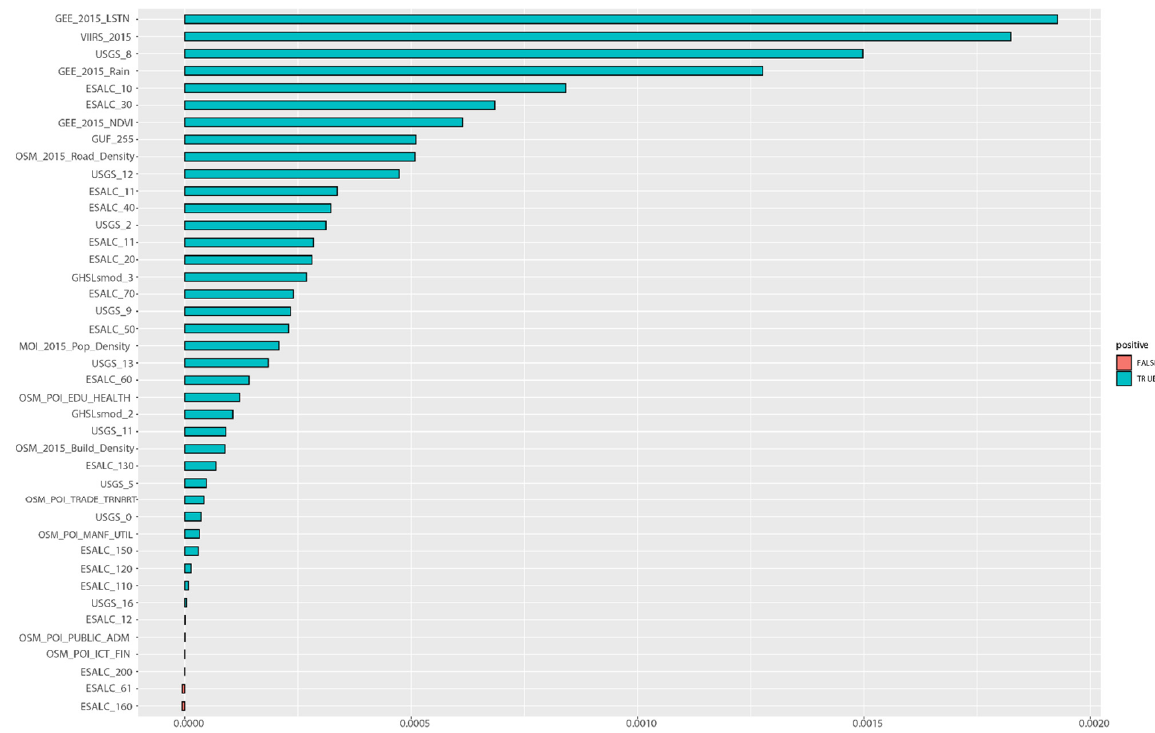
Figure 14. Result of Variable Importance (VIMP) analysis on predicting poverty headcount rates of 2015 (based on RF’s outcome). Source: Calculation and graphics generated by authors.